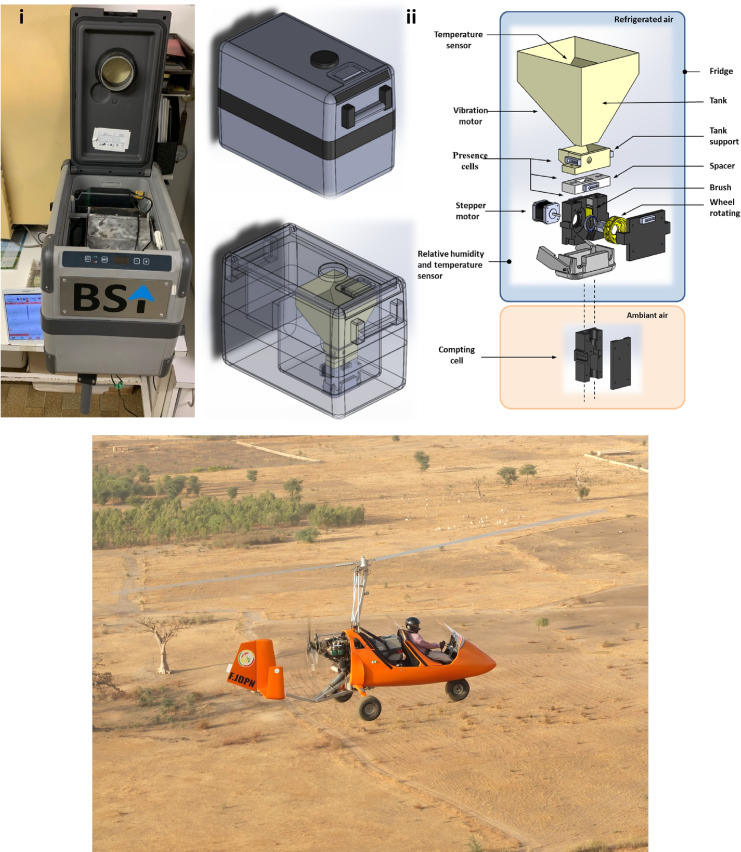
The BSITM machine.A, images showing (i) top view of the open BSITM displaying the storage funnel where tsetse flies are held at 6°C, (ii) 3-dimentional technical drawing showing different parts of the BSITM release machine; B, the BSITM release machine loaded on a gyrocopter during field operation.